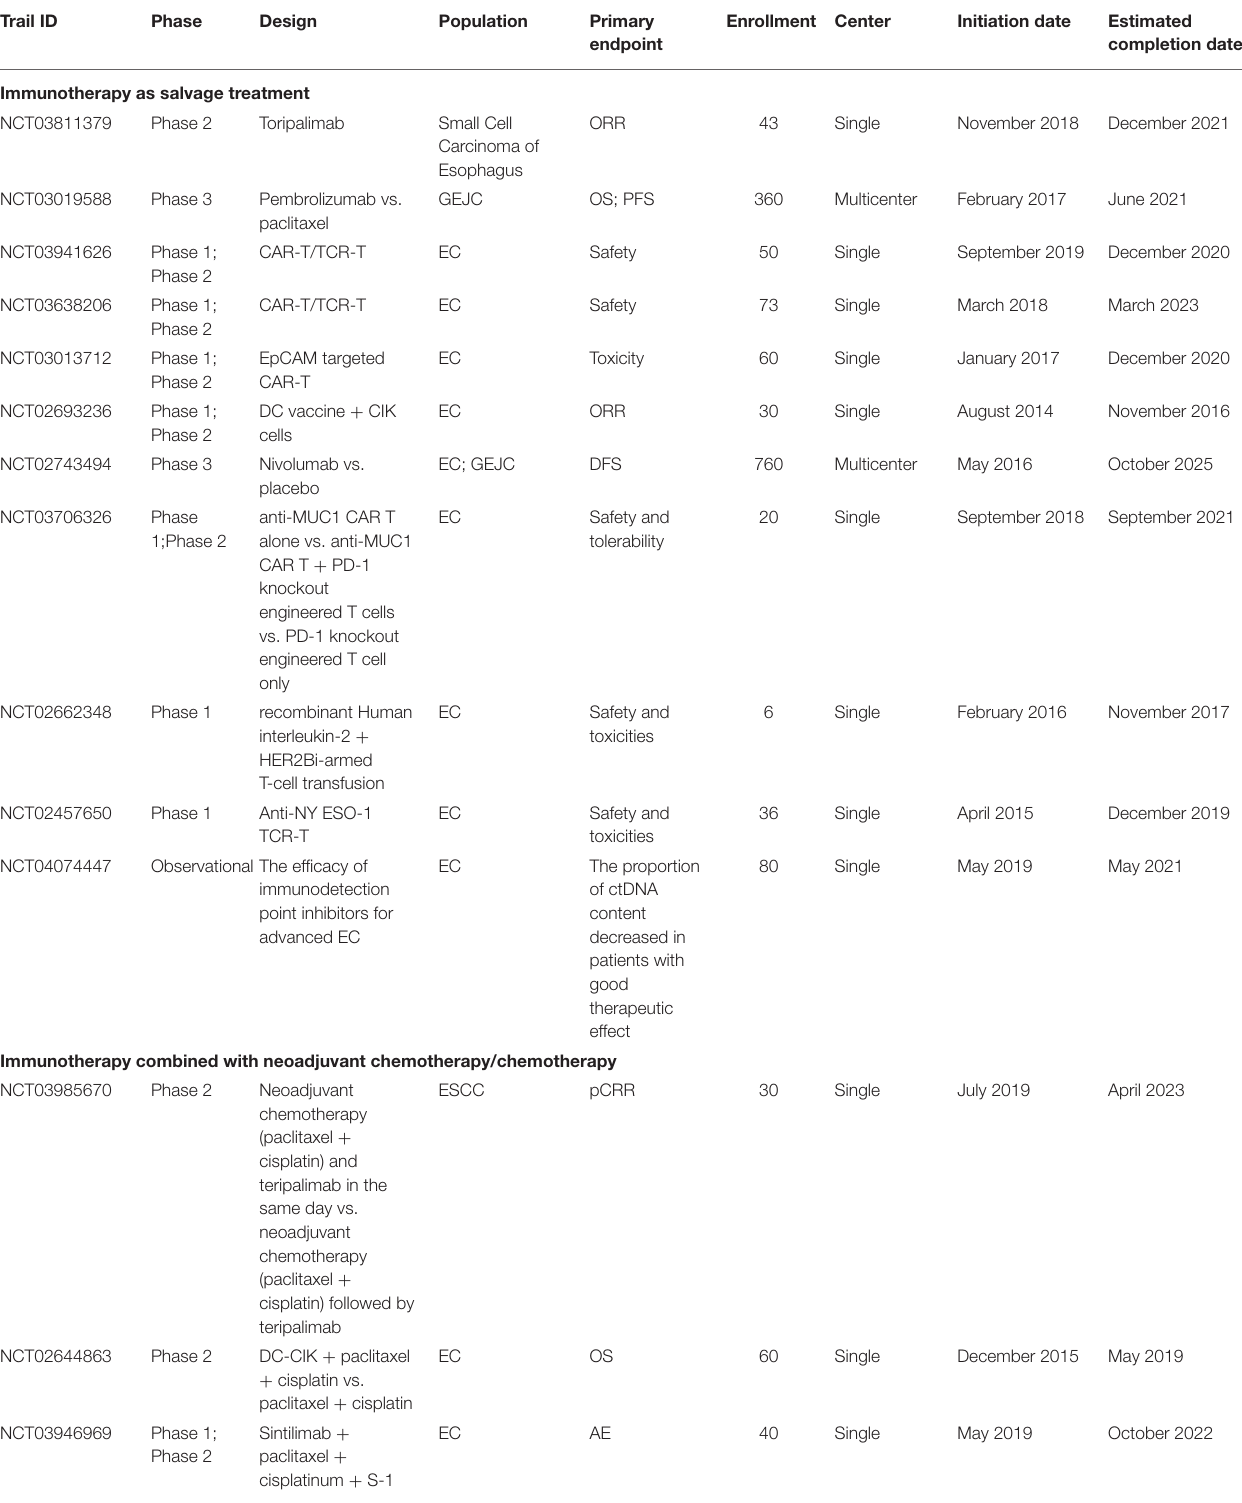
TABLE 2 | Ongoing clinical trials of immunotherapy for esophageal cancer in China. Trail